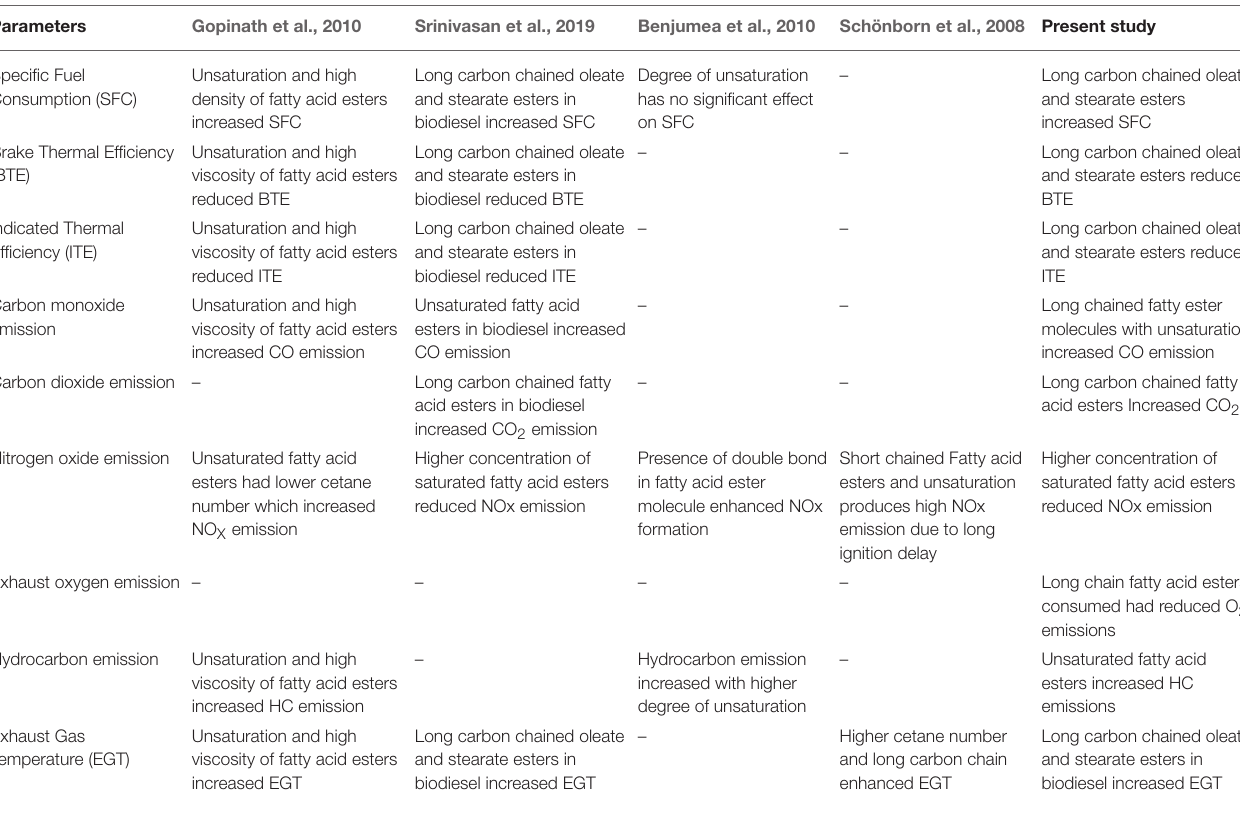
TABLE 6 | Comparison of Engine characteristics from present study with existing